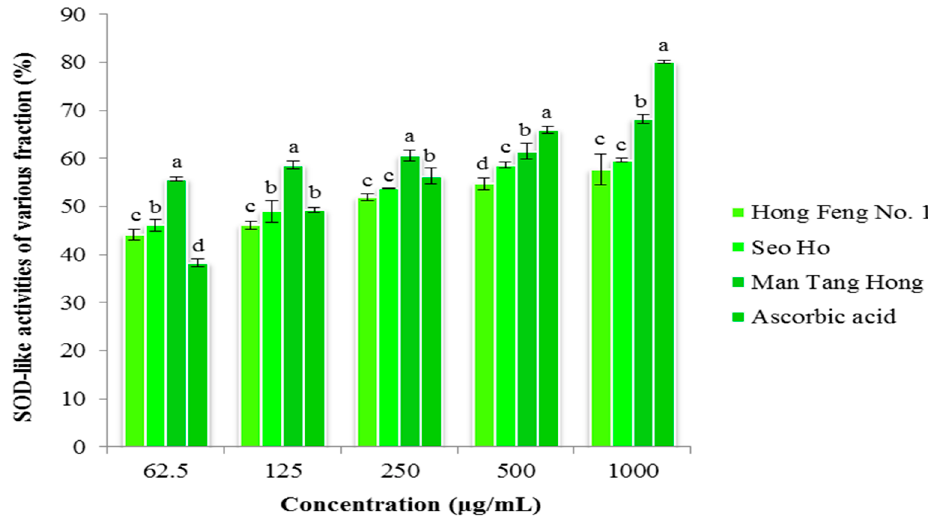
Figure 3. Superoxide Radical Scavenging activity of various fractions from Raphanus sativus. All the values in the figure are expressed as means (%) of triplicated experiments ± SD of three experiments. Mean values in a different letter (a, b, c and d, respectively) were significantly different at p < 0.05 using Duncan Multiple Range Test (DMRT).